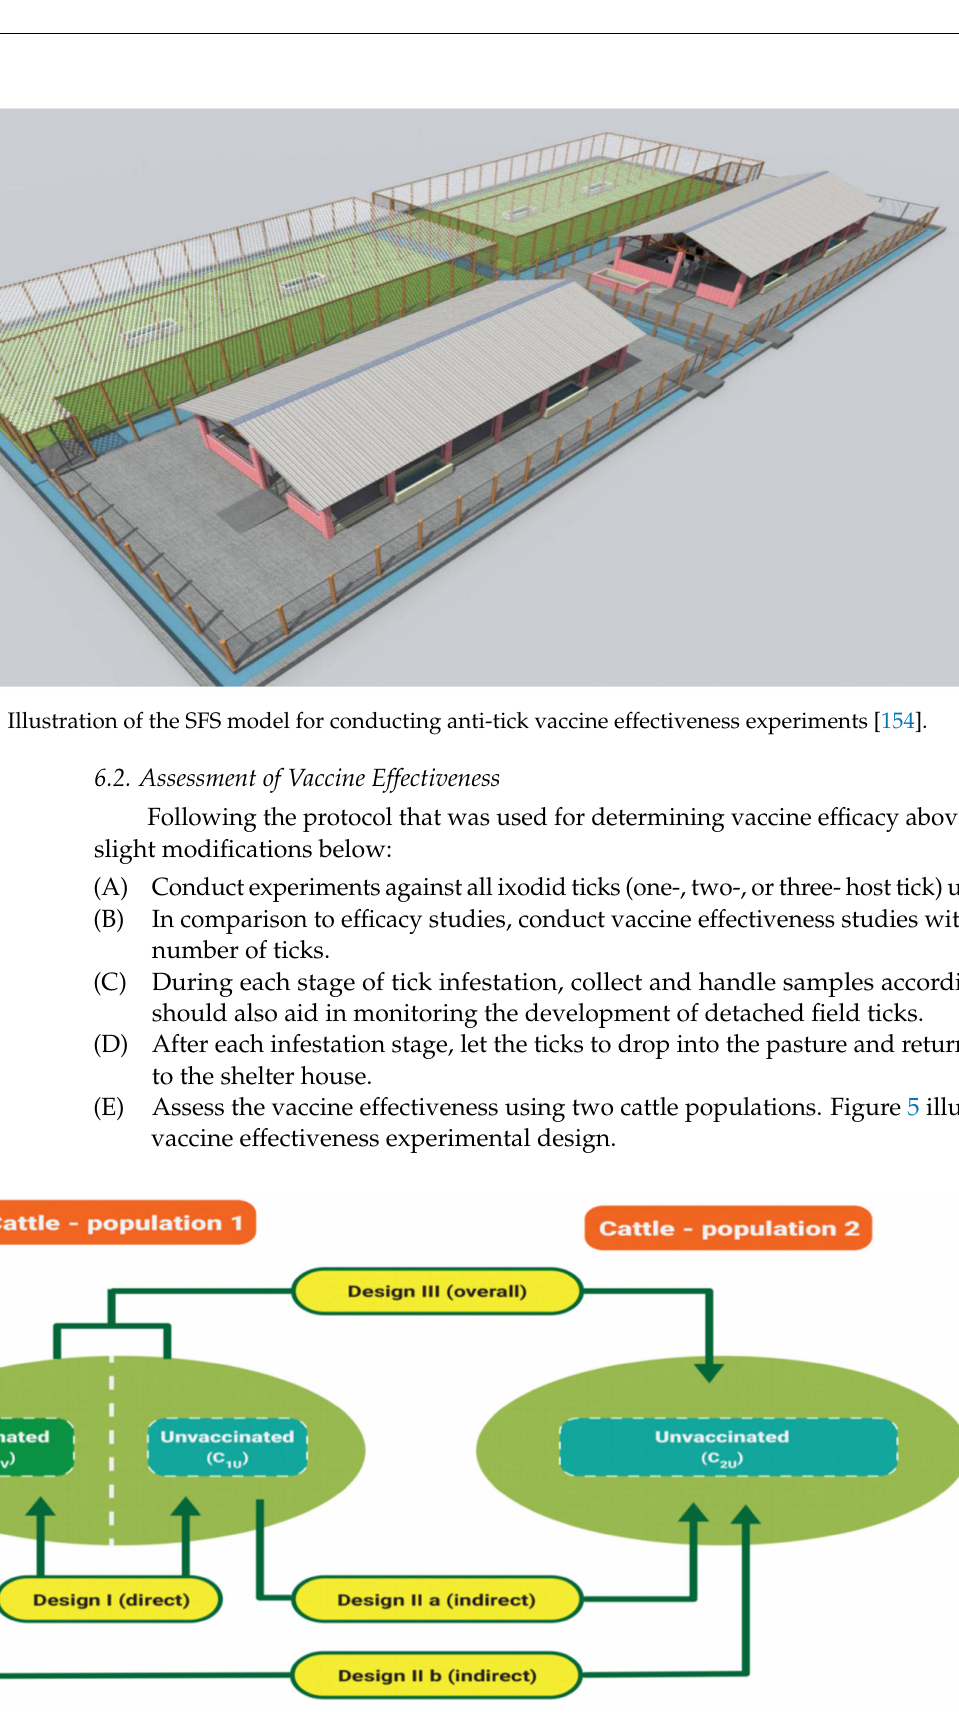
Figure 5. Illustration of the experimental design for assessing anti-tick vaccine effectiveness (adopted from [155]). The assessment is performed using two cattle populations. In Population 1, both the vaccinated (C 1V ) and unvaccinated (C 1U ) cattle are kept together, while in Population 2, only unvaccinated (C 2U ) cattle are present. The two populations are